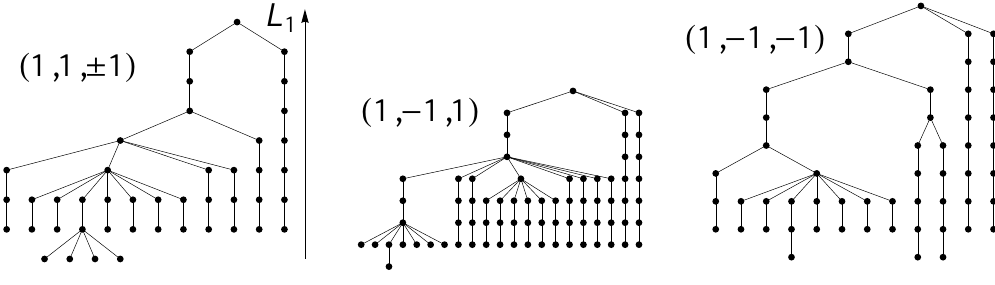
Figure 11: Configuration space of low-winding numbers as four hierarchical trees (one for each invariant ( 1, ± 1, ± 1 ) , two are identical by symmetry). Each point rep- resents a Kempe sector. The level n ≥ 0, from bottom up corresponds to the system = 6 + 3 n , i.e. higher winding numbers allowed. Only the lowest two levels size, L 1 n = 0,1 include all the sectors. For n ≥ 2, additional sectors are not